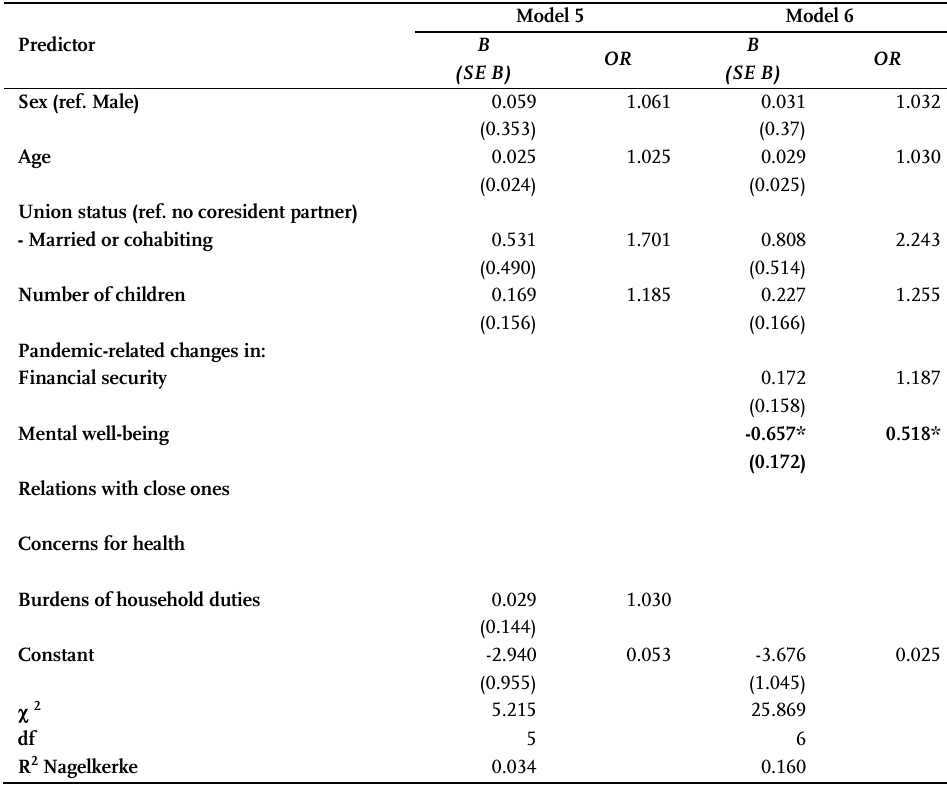
Model 5 Model 6 B OR OR (SE B) (SE B)